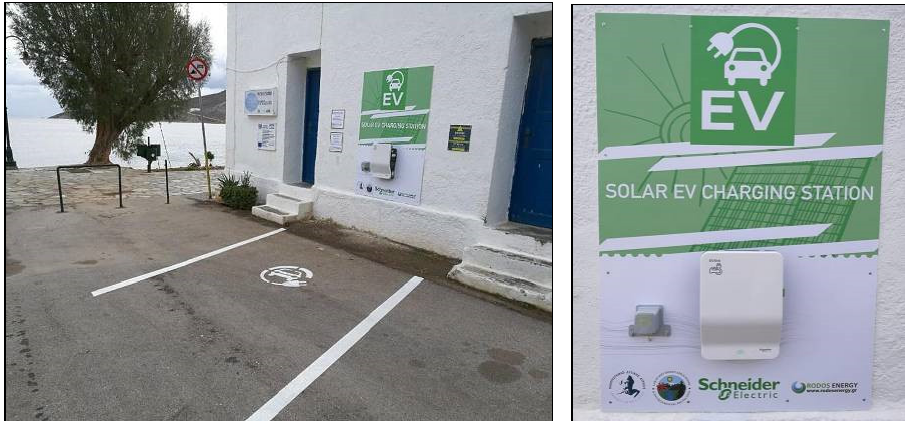
Figure 10. Photos of the charging area and EV charger at TILOS info-kiosk in